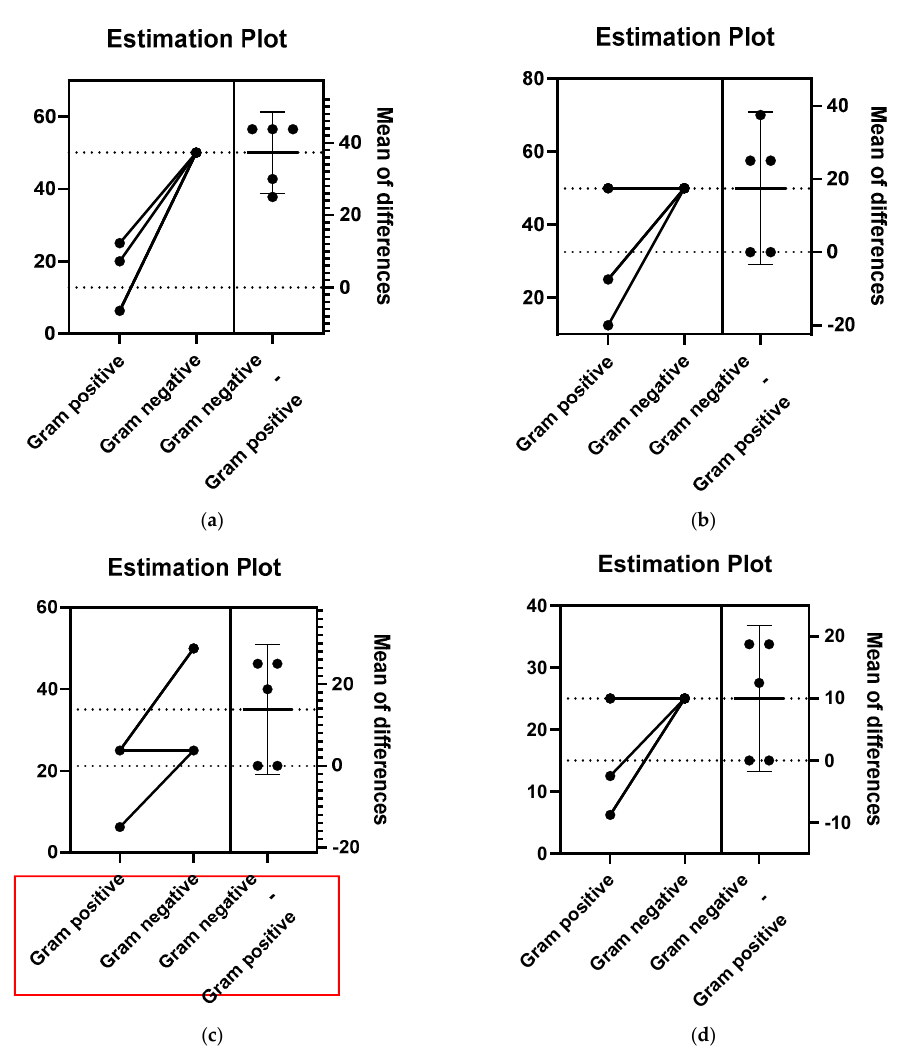
Figure 2. Estimation plots of the antibacterial activity of the P. abies ( a ), L. decidua ( b ), P. menziesii ( c ) and P. nigra ( d ) EOs. The Gram-negative–Gram-positive effect size is generated by the difference between means. The precision of the calculated effect size was at a 95% confidence interval.